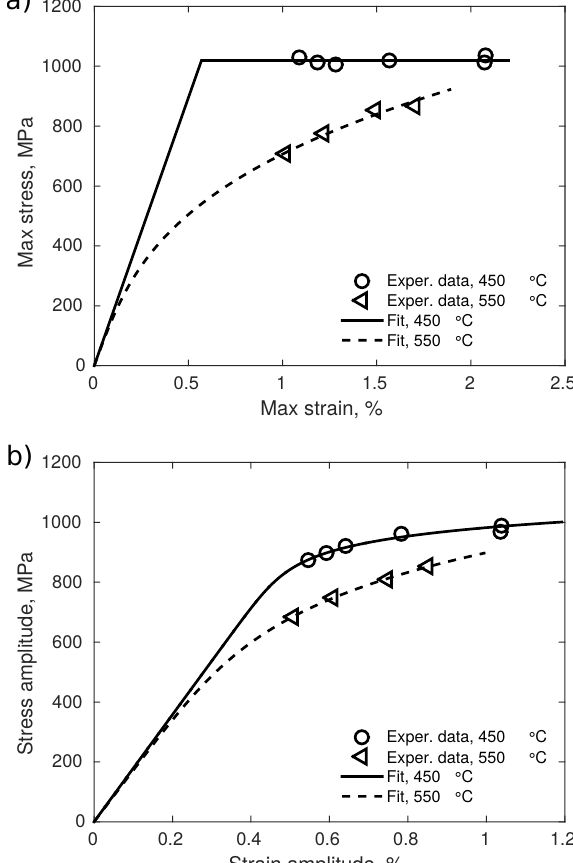
Figure 1. Material behaviour at 450 °C and 550 °C based on data from Ref. [7]. a) Maximum stress versus maximum strain. b) Stress amplitude versus strain